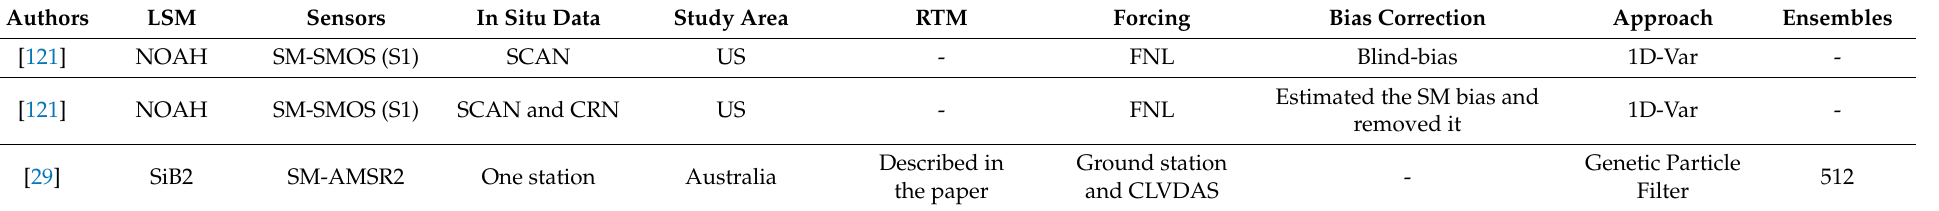
Table 6. RSM correlation improvements greater than 0.09 for papers reviewed in this